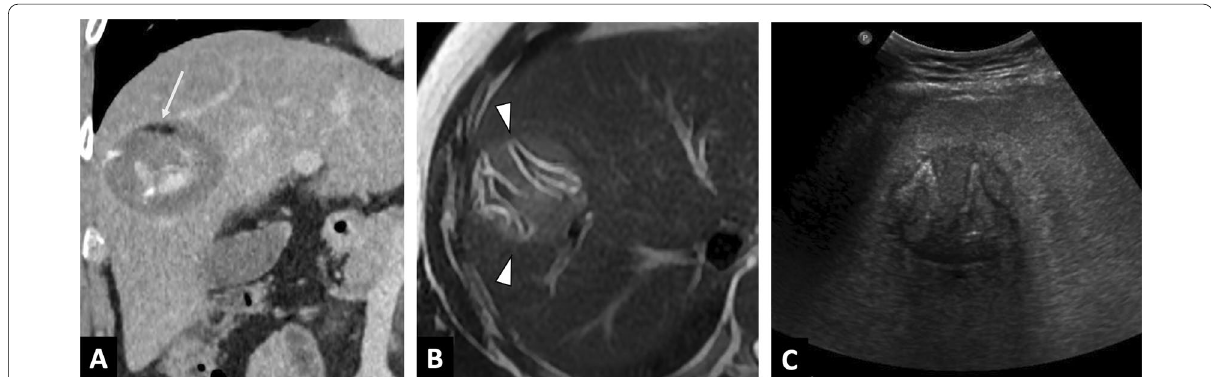
Fig. 16 Cystic echinococcosis lesion CE4 with negative result on serology test. A CT image in the coronal plane obtained during the portal phase of enhancement: CE lesion of the right lobe with calcified membrane, leads to complementary exploration in MRI and US to assess activity. Note the